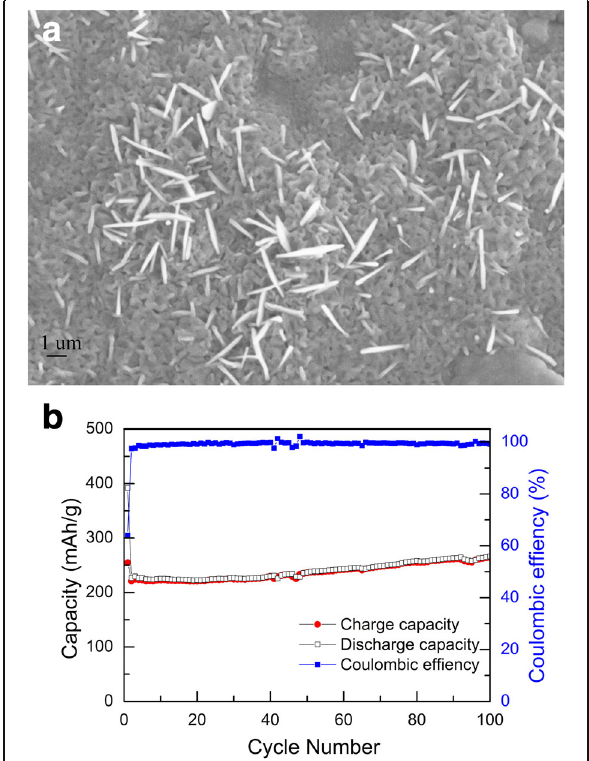
Fig. 5 a SEM image and b cycling performance of the Fe 2 O 3 film anode annealed at 400 °C at a specific current of 100 mA g −